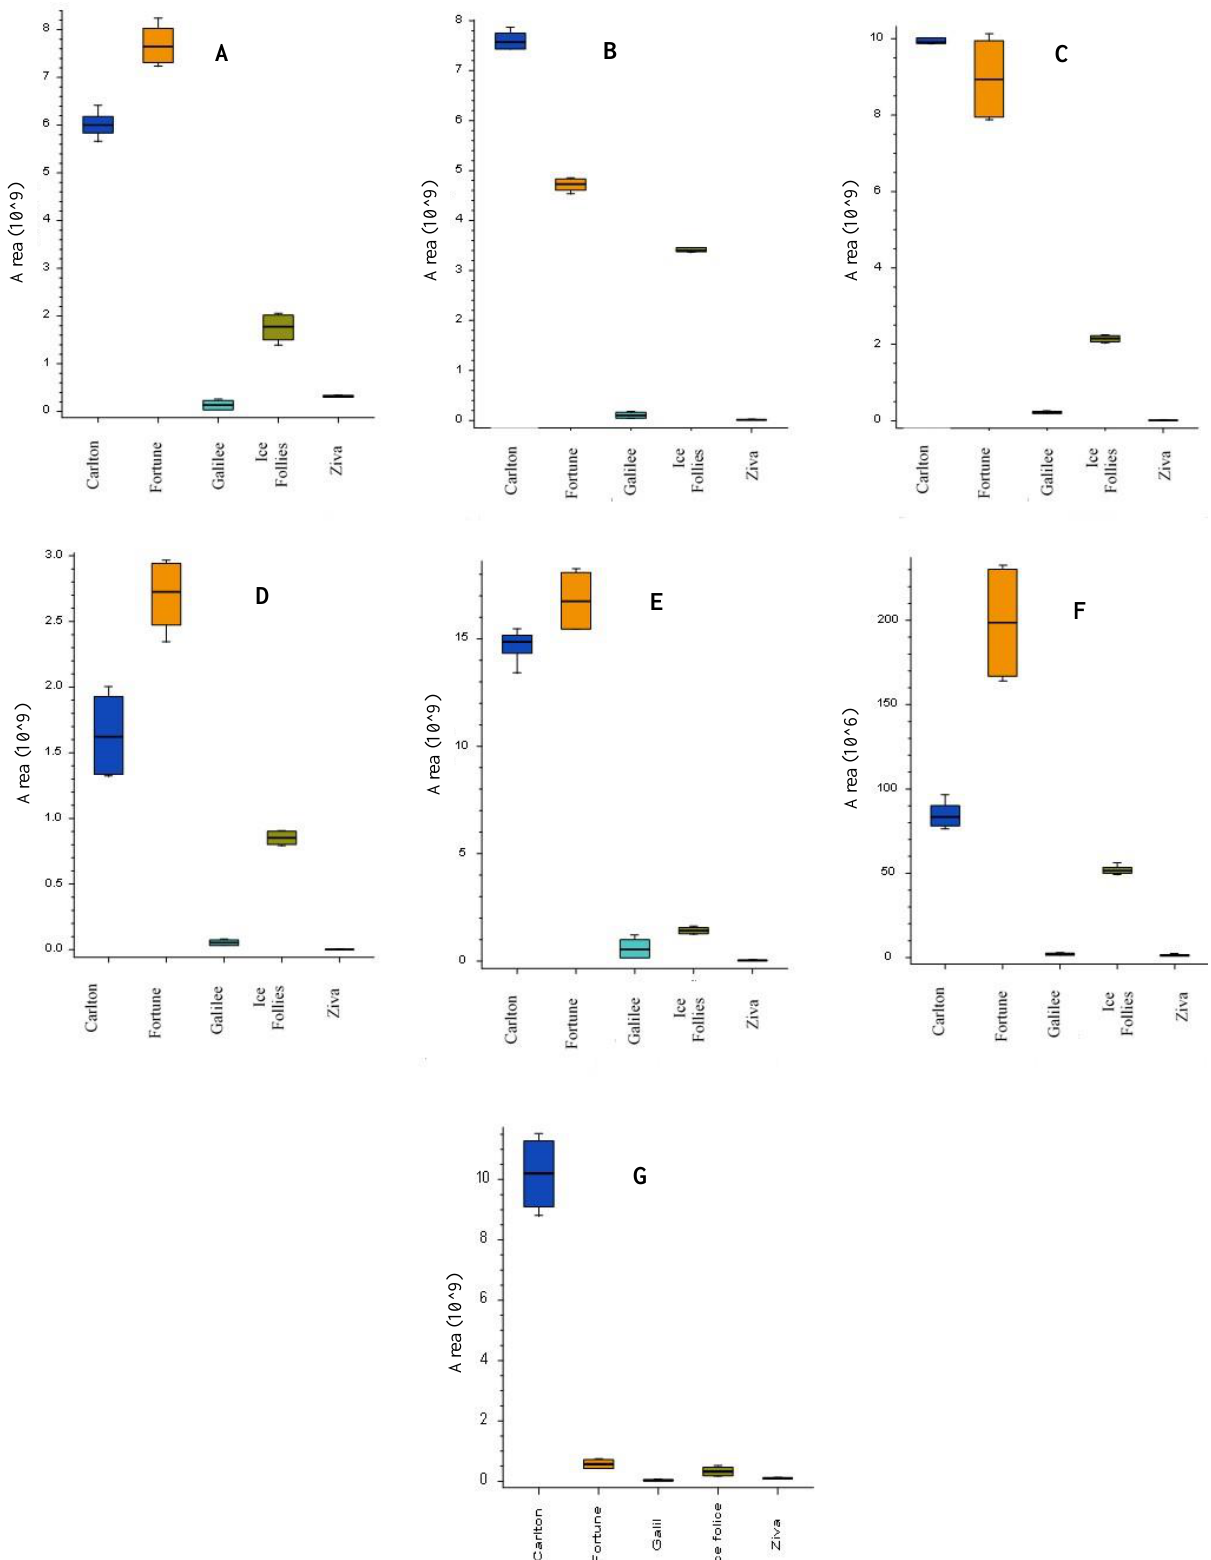
Figure 4. The distribution of the compounds carinatine ( A ), norgalantamine ( B ), galantamine ( C ), lycoramine ( D ), galanthine ( E ), narweden ( F ) and narcissidine ( G ), detected mainly in the Carlton and Fortune cultivars presented as box plots. The figures present the mean area values obtained from four extracts for each cultivar ( n = 4), where the limit of the lower and upper quartile and the minimum and maximum of the distribution are presented as error